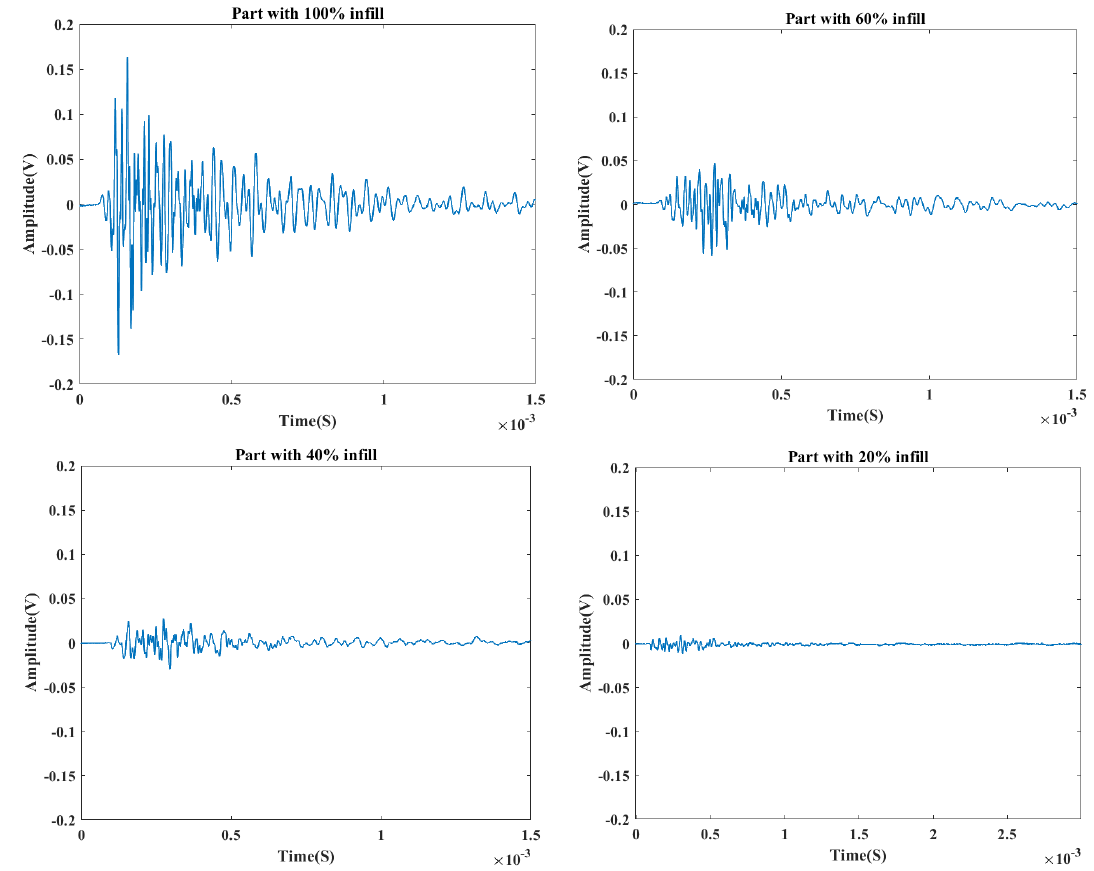
Figure 11. Response to the pulse excitation at Sensor 2 in all the specimen .